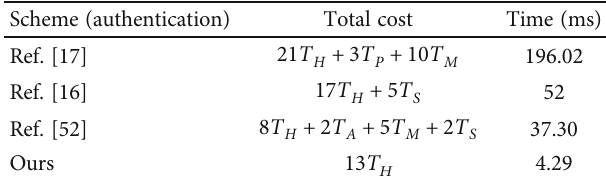
Table 3: Performance comparison (computation